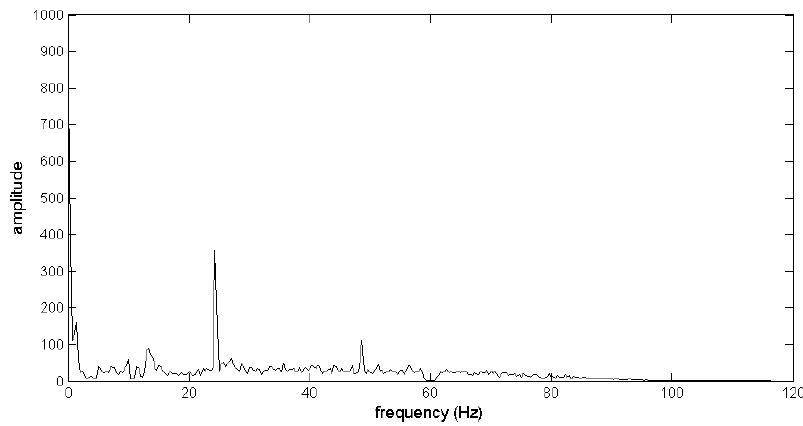
Figure 4. Spectrum of the 3-s EEG signal at Oz of one subject. The LED flickering frequency is 24.39 Hz.